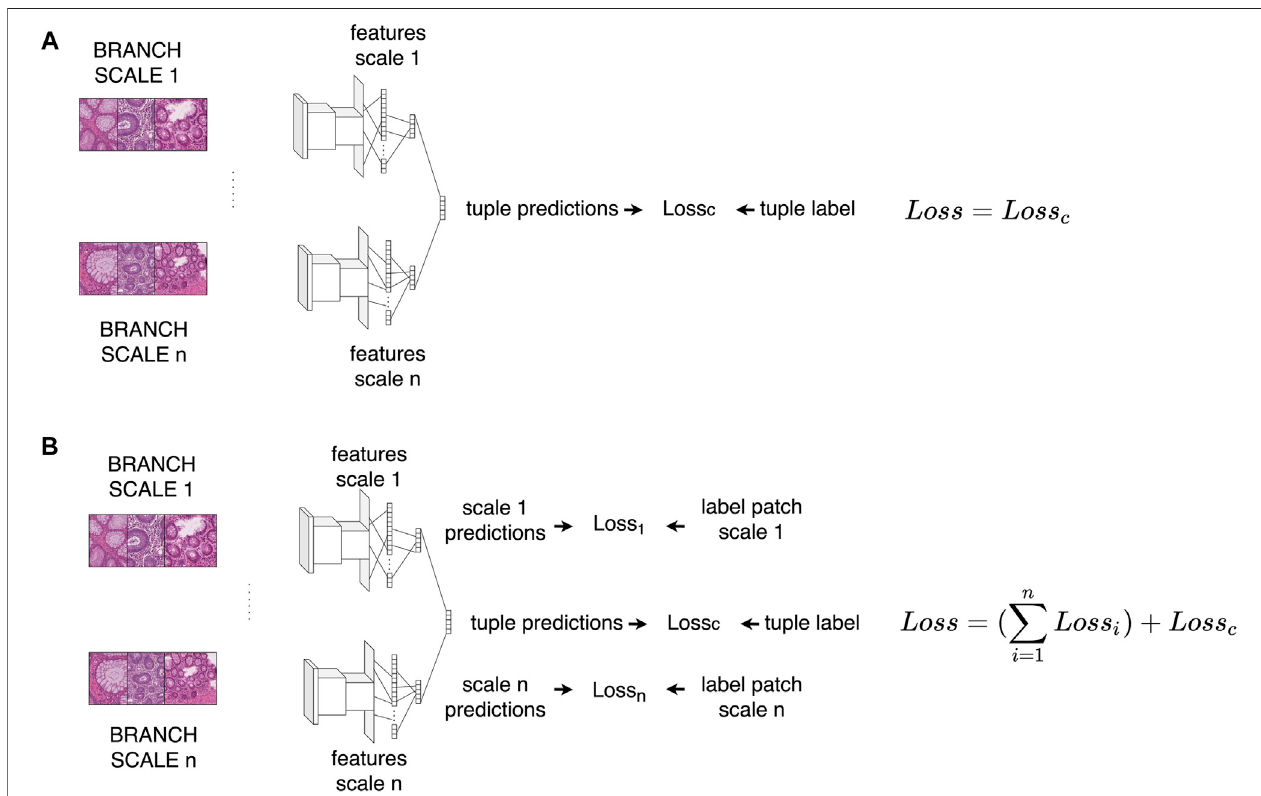
FIGURE 6 | The second multi-scale CNN architecture, in which predictions are combined from different scale branches, optimizing only one loss function (A) and optimizing n + 1 loss functions (B) .